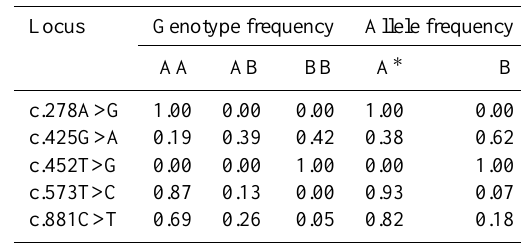
Table 2. Genotype and allele frequencies of the porcine OPN gene in Thai Large White